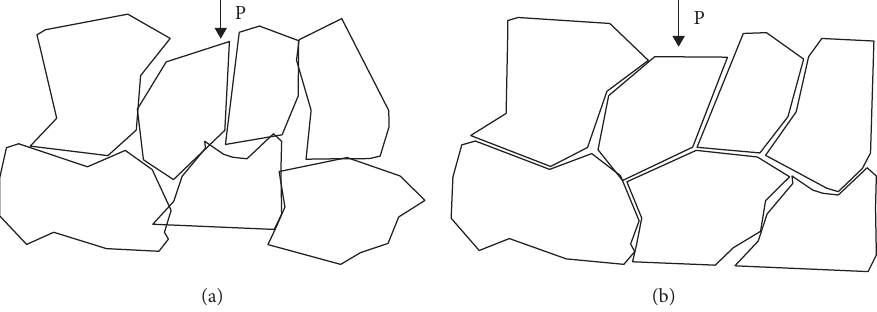
Figure 13: Changes of concrete particles under external